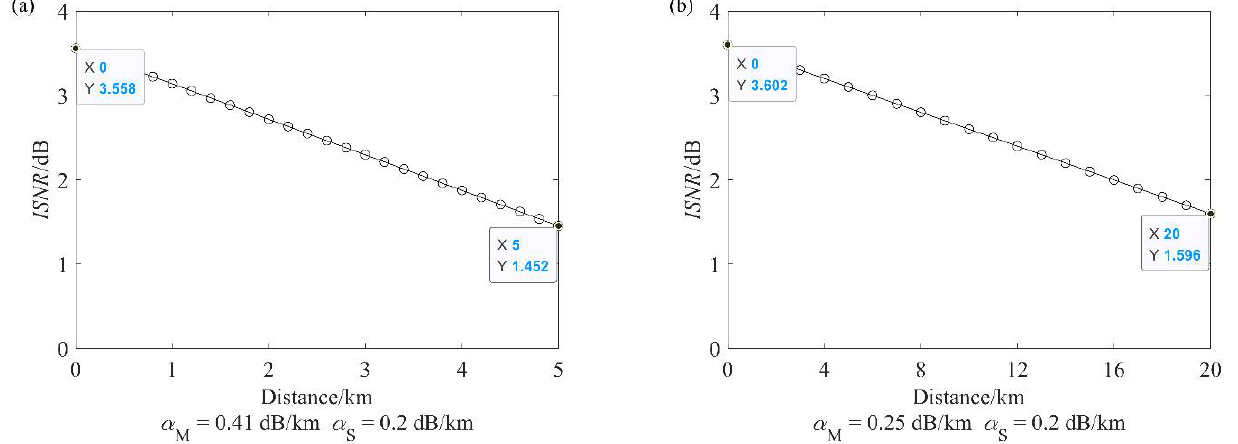
Figure 2. The calculated ISNR of the designed sensing structure over SMF in the BOTDR system. ( a ) 5 km; ( b ) 20 km.